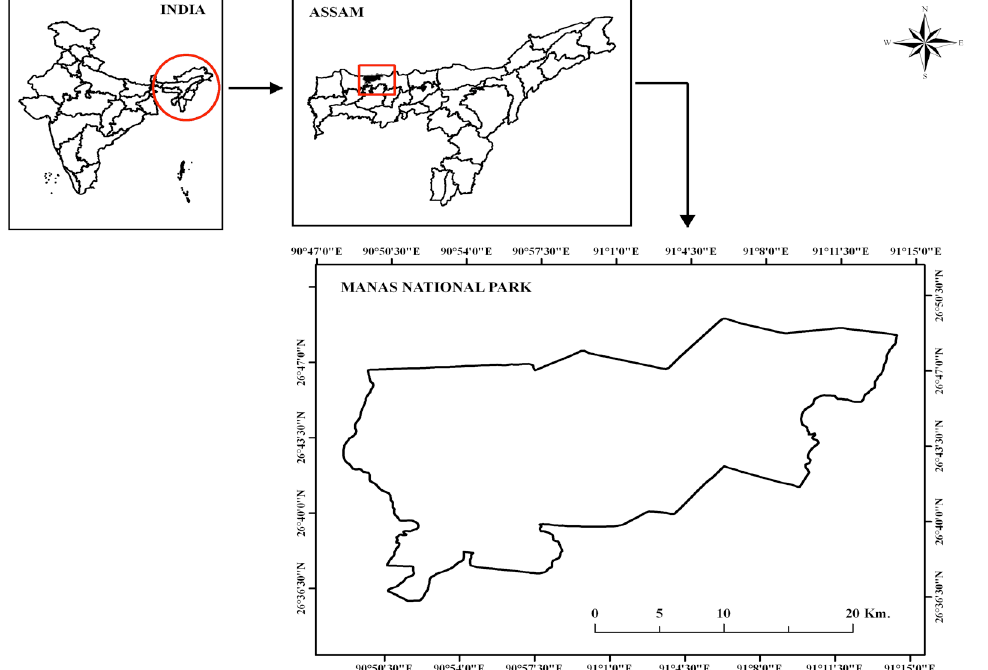
Figure 1. The study area - Manas National